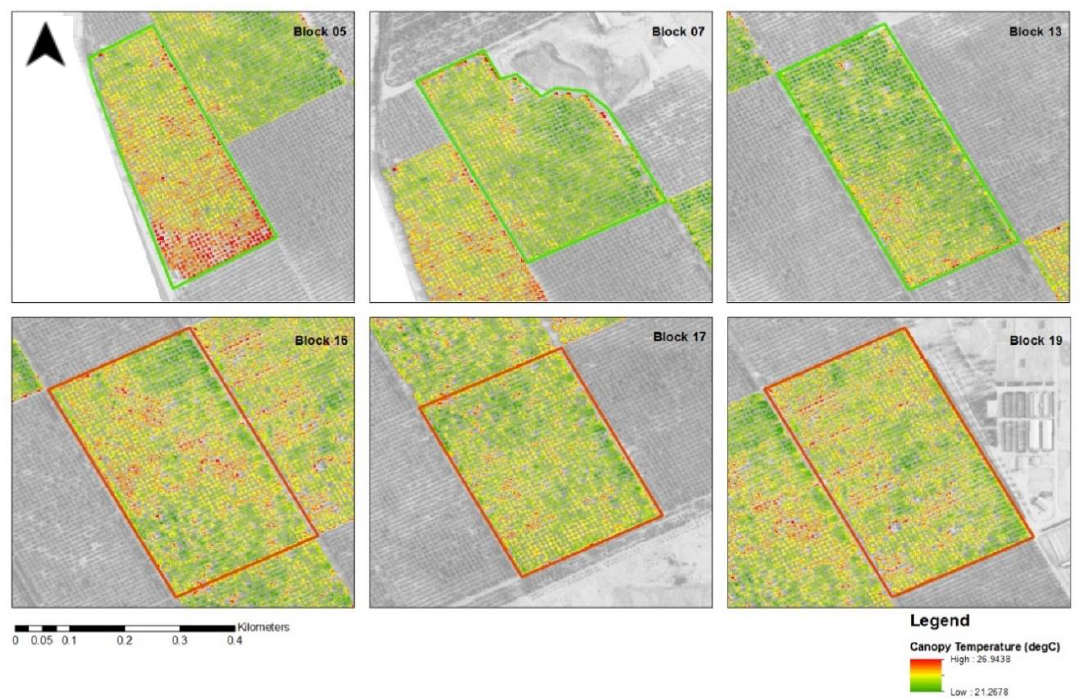
Figure 7. Temperature of the extracted canopy pixels representing individual trees for the test blocks.